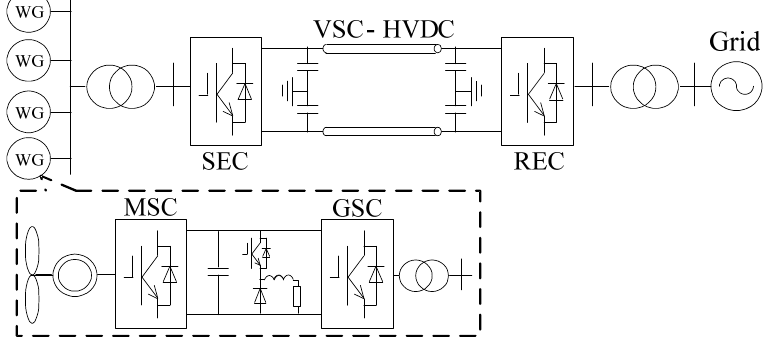
Figure 1. VSC-HVDC-based PMSG wind power